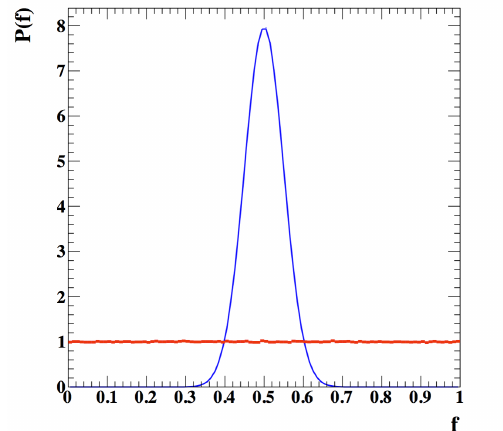
Figure 1. Probability distributions of the fraction of neutral kaons for generic and DCC